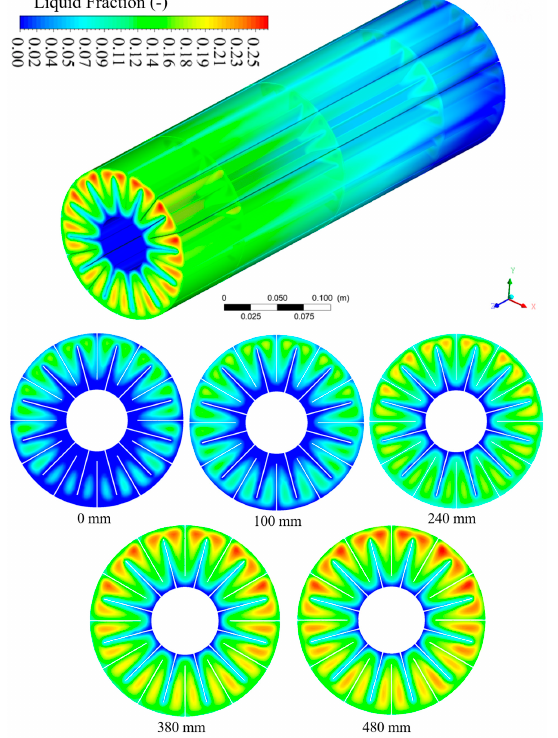
Figure 17. PCM liquid fraction distribution for 10% of volume in a liquid state (t = 10293 s). In Figure 14, within a range of 48 to 100% liquid fraction, the following characteristics can be observed: in the TTHX inlet section (z = 0 mm), fractions with 48% in a liquid state were deposited in regions close to the upper face of the internal surface and the lower face of the external surface of the annular; in the section at z=100 mm, these fractions were only found in the regions close to the upper face of the annular internal surface; in the section at z=240 mm, only liquid fraction values greater than 62% are found; for the sections at z = 380 and 480 mm, values were above 70%. This distinct behavior along the material length is due to the CHTF heating process, which decreases the temperature gradient between it and the PCM as it crosses the sections of the TTHX. The last two sections (z = 380 and 480 mm) presented very similar configurations, indicating that for this instance in the process, this reduction in the solidification potential has no significant effect on the lengths of the referred sections.